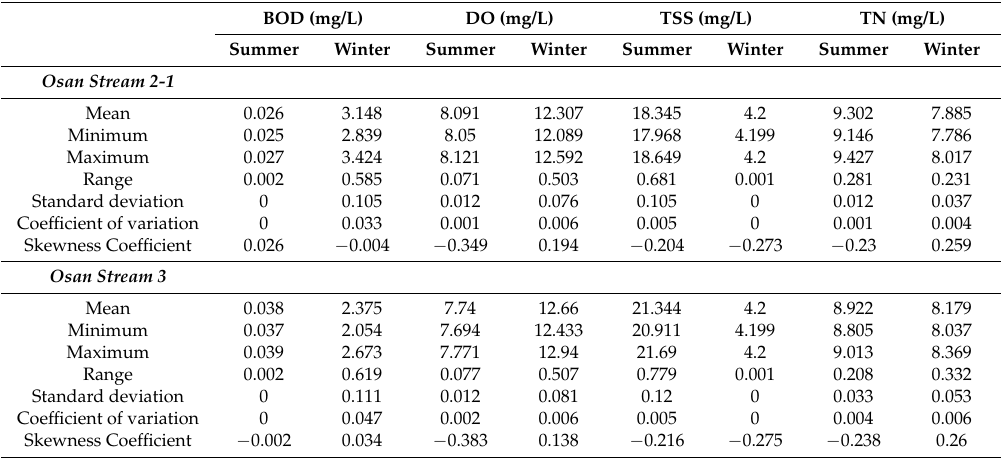
Table 4. Monte Carlo Simulation summary for BOD, DO, TSS, and TN at proposed reuse station.